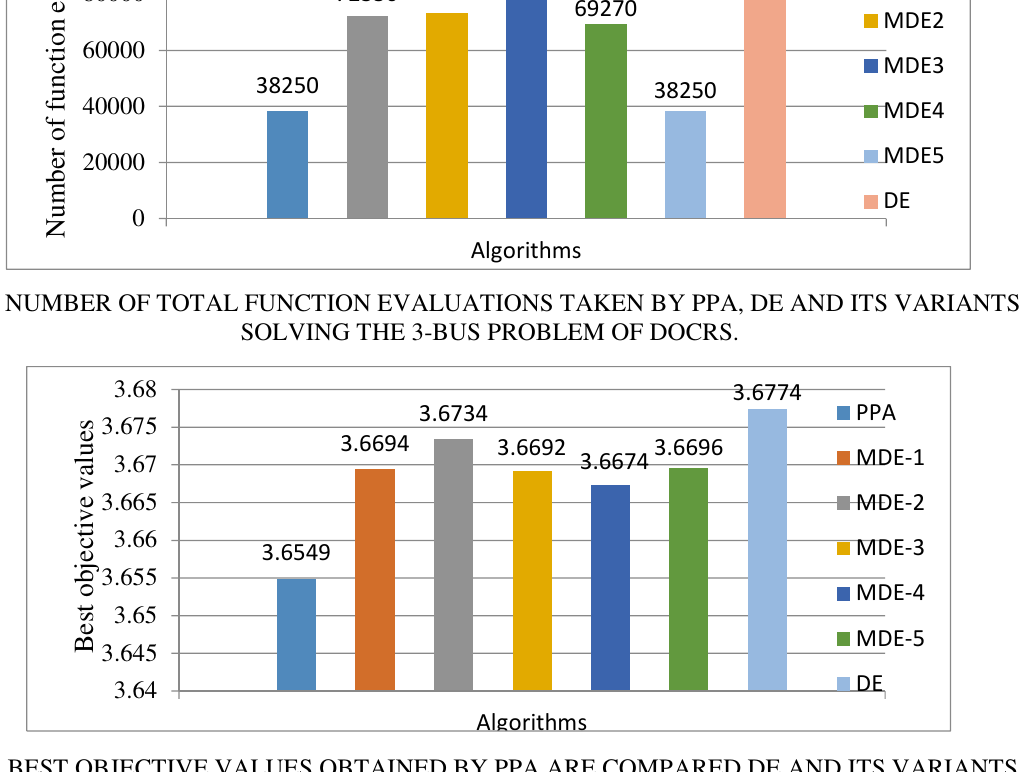
FIG. 6: BEST OBJECTIVE VALUES OBTAINED BY PPA ARE COMPARED DE AND ITS VARIANTS IN SOLVING THE 4-BUS PROBLEM OF